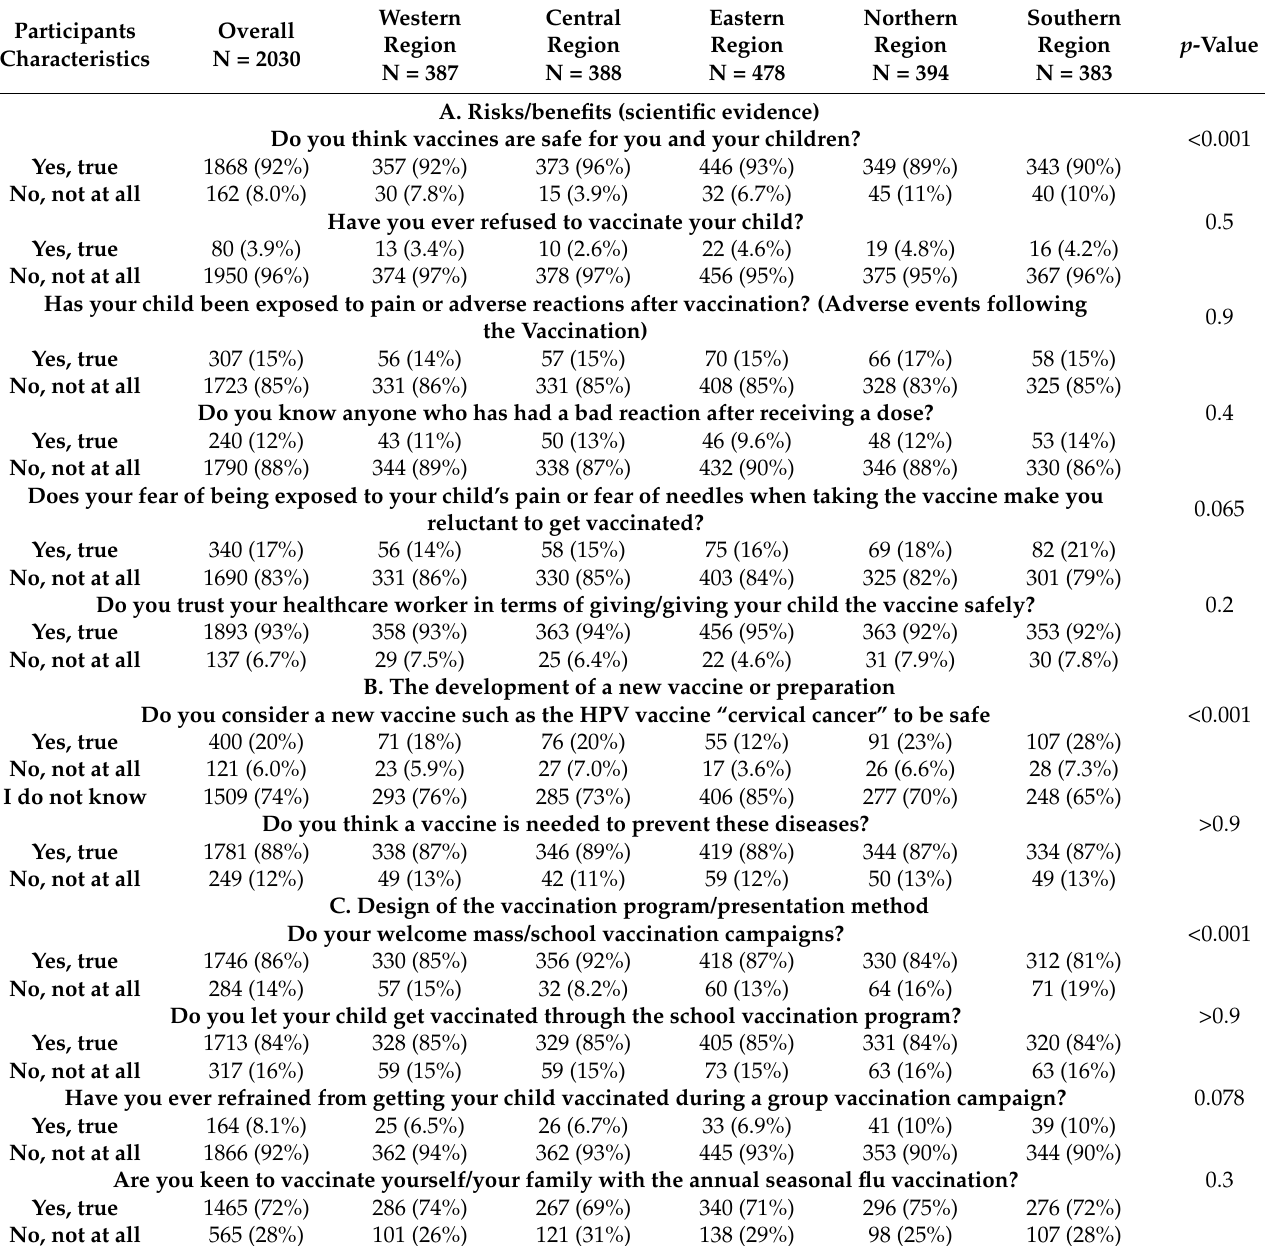
Table 4. Survey questions to assess vaccine/vaccination specific issues of vaccine